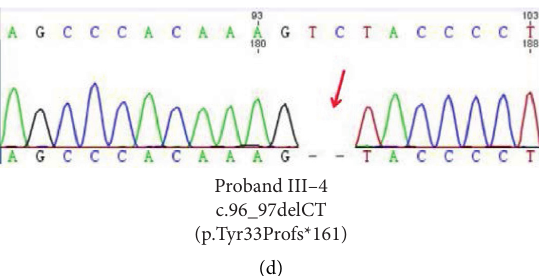
Figure 2: Pedigree diagrams and genetic analysis of two cases. (a), (c) Pedigree diagrams of the case one and case two with X-linked ALD, respectively. Empty square and circle show healthy male and female. Dark square represents patients with X-ALD. Diagonal stripes show heterozygous carrier. Arrow represents hemizygous proband. (b) Genetic analysis revealing novel mutation of c.874_876delGAG (p.Glu292del) of ABCD1 gene in patient one (proband III-7) and his mother (II-10). (d) Novel mutation c.96_97delCT (p.Tyr33Profs ∗ 161) detected in patient two (proband